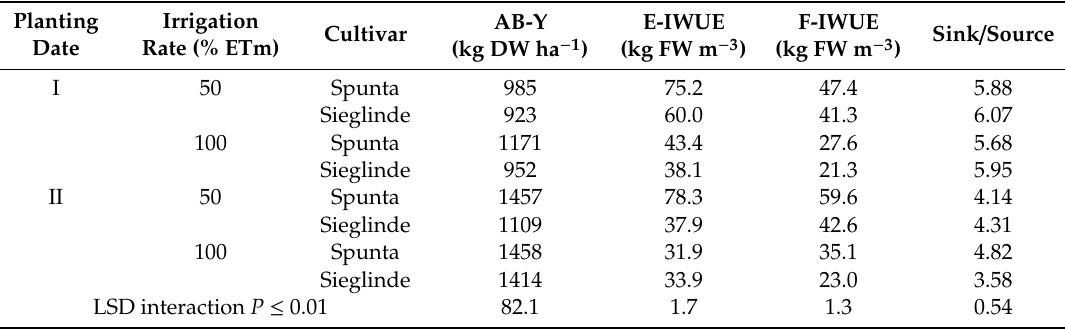
Table 3. Aboveground dry biomass yield (AB-Y), Irrigation Water Use E ffi ciency at early harvest (E-IWUE) and final harvest (F-IWUE) and Sink / source as a ff ected by interaction ‘planting date × irrigation rate × cultivar’.